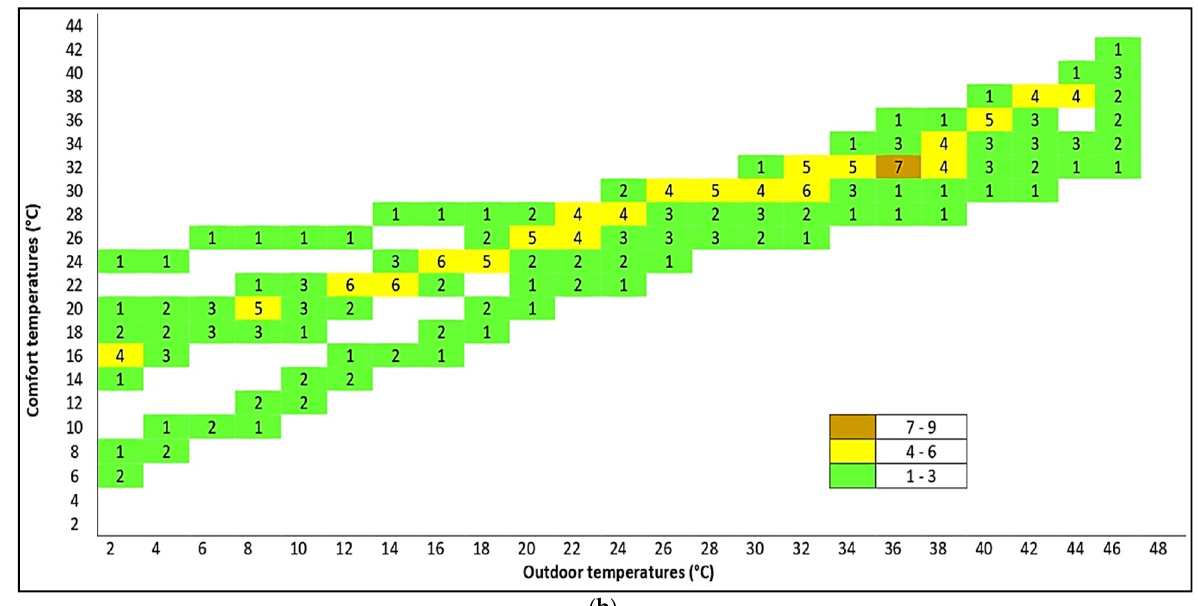
Figure 4. ( a , upper ) Linear models of comfort temperatures vs. outdoor temperature for hot-dry climates according to Table 2. ( b , lower ) Distribution of event probabilities divided into regions. The rectangles include the number of lines that pass through a specific region. Color codes represent the number of events: green = 1–3, yellow = 4–6 and brown = 7–9.